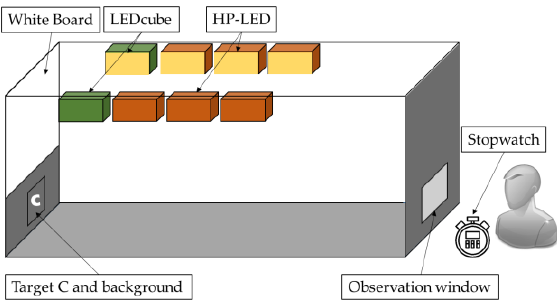
Figure 7. Schematic diagram of experimental set-up. HP-LED refers to the high power LED. Target C refers to the Landolt chart applied in the experiment.